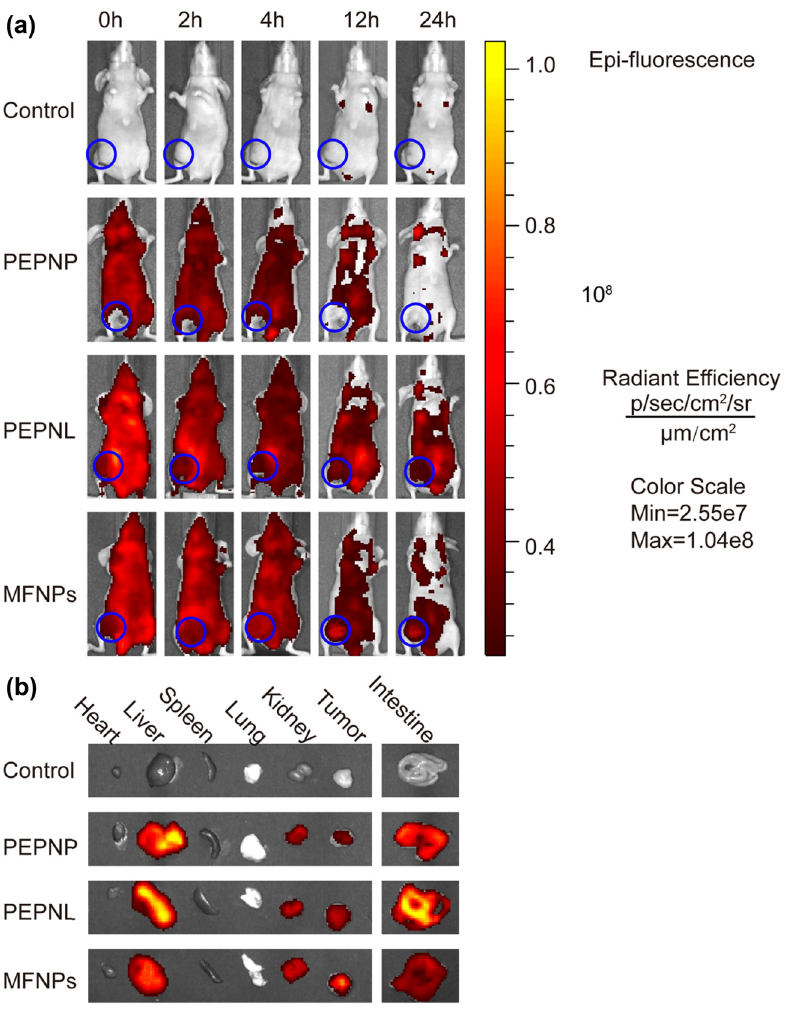
Figure 4: ( a ) In vivo distribution of PBS control, PEPNL NPs, and MFNPs groups at 24 h. ( b ) Organs distribution of control, PEPNP NPs, PEPNL NPs, and MFNPs groups at 24